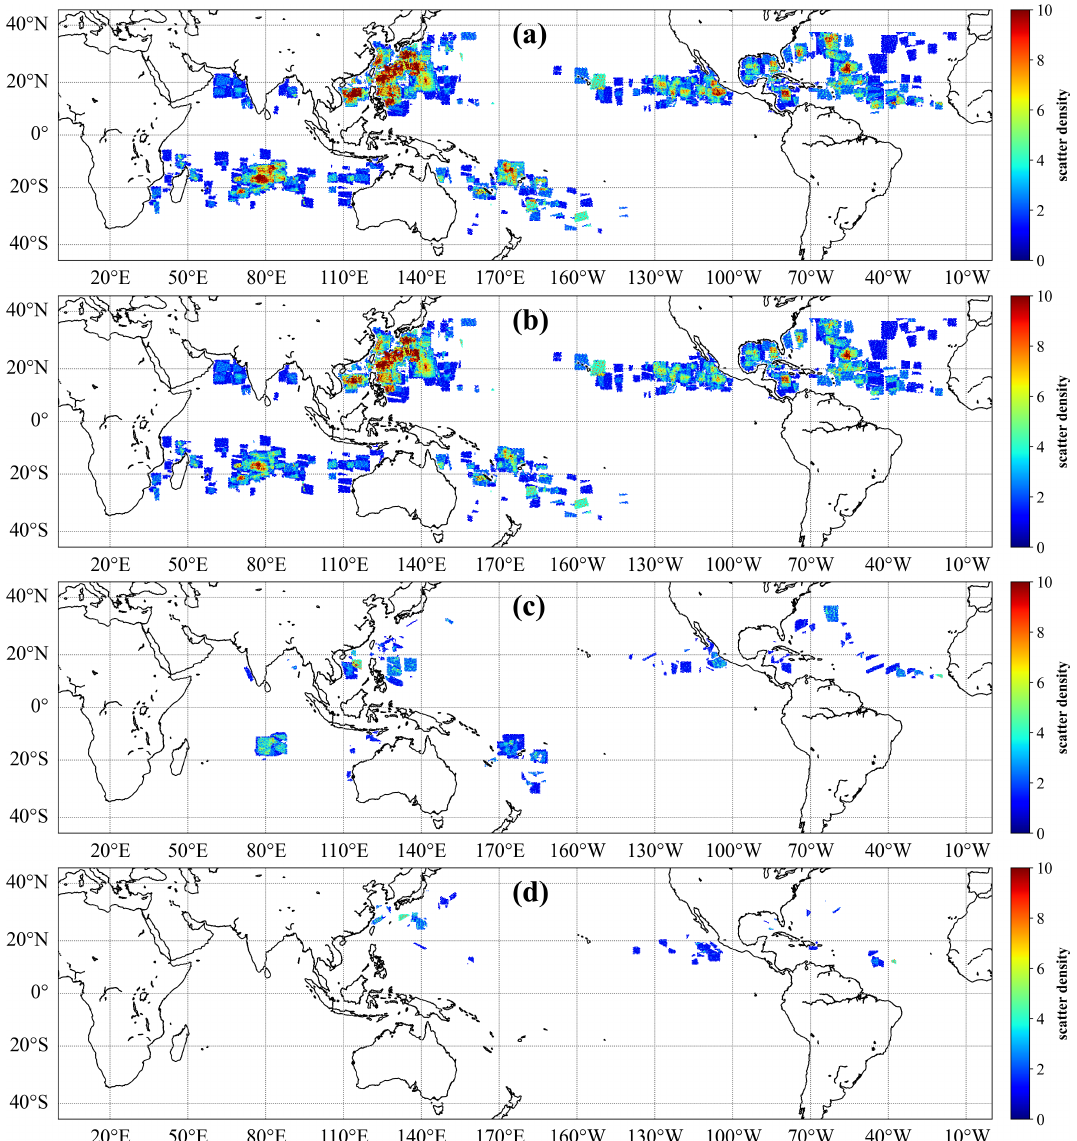
Figure 2. Global distribution of collocations between HY-2B/C/D series scatterometers and the SMAP radiometer under tropical cyclone conditions during 2019–2021 (0.25 ◦ × 0.25 ◦ grid). ( a ) Number of collocated HY-2B/C/D scatterometers and the SMAP radiometer; ( b – d ) are the same for HY-2B, HY-2C, and HY-2D,